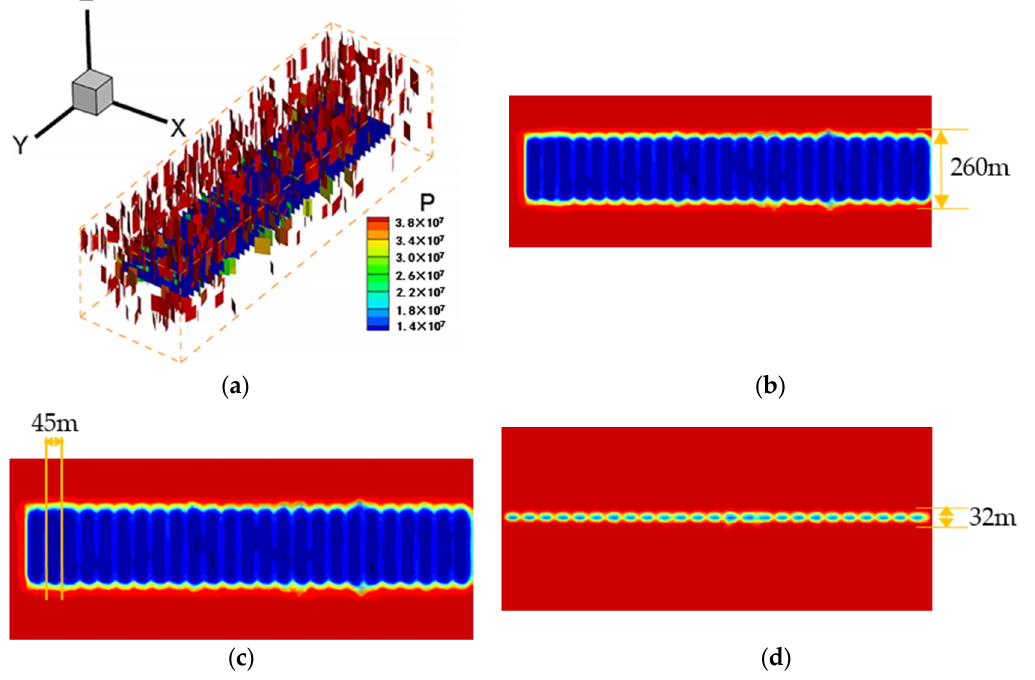
Figure 6. Pressure changes and reservoir utilization range after 15 years of medium-density (0.006 m/m 2 ) natural fracture reservoir exploitation: ( a ) Pressure field diagram; ( b ) Utilization range in X direction; ( c ) Utilization range in Y direction; ( d ) Utilization range in Z direction.